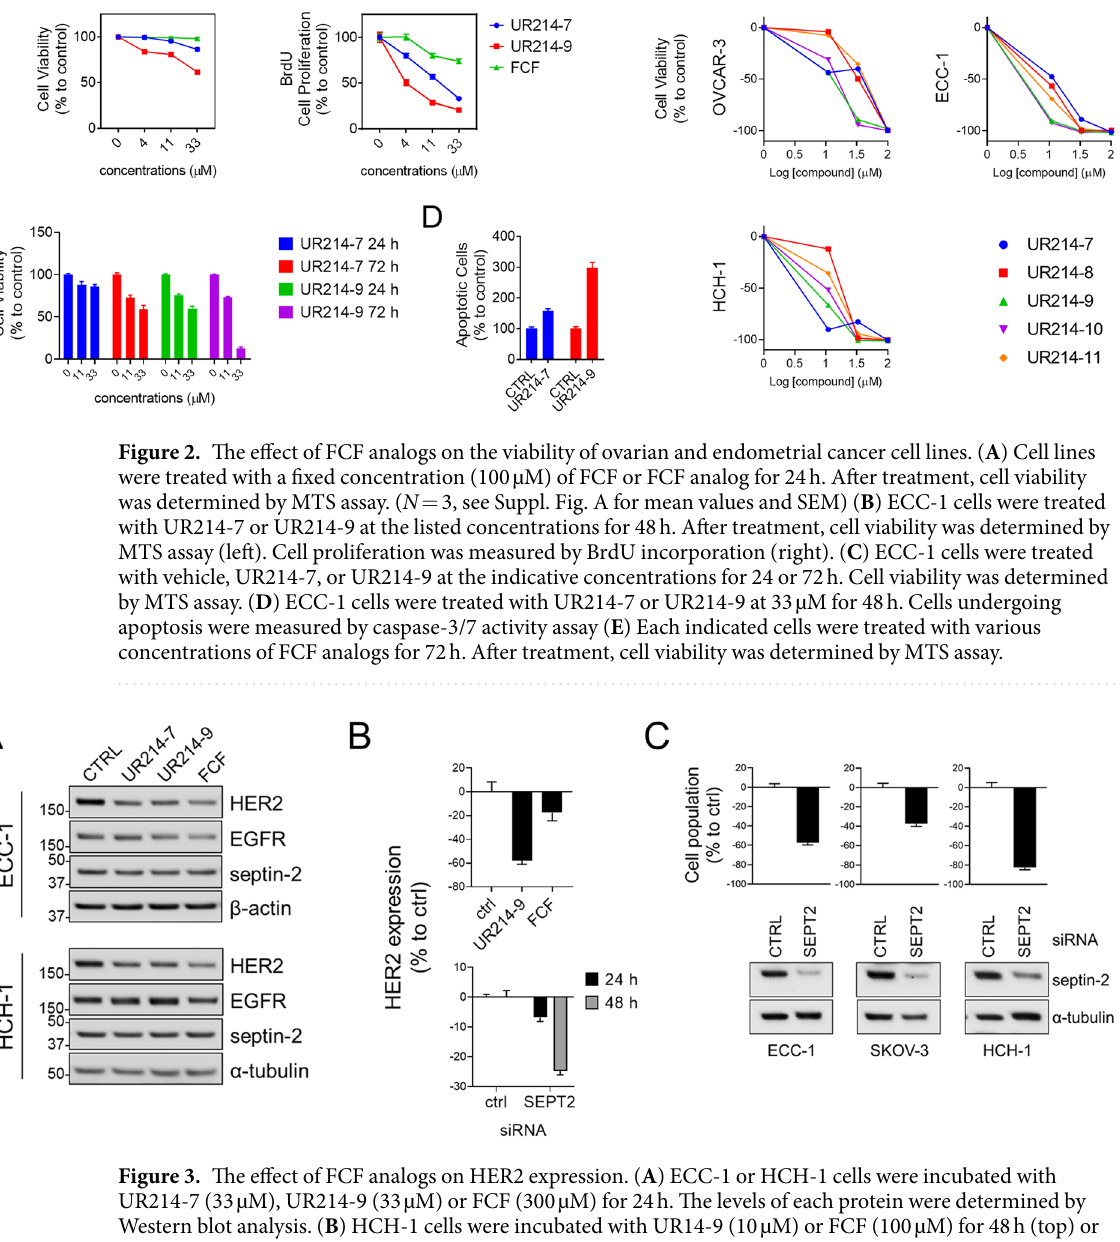
profiled septin expression in ovarian cancer-associated vs. normal ovarian stroma were also analyzed (Wong- 77-MAS5.0-u133p2). In cancer-associated stroma, the expression of septin-2 and septin-9 was significantly upregulated, while septin-6 and septin-7 were unchanged (Fig. 5C).